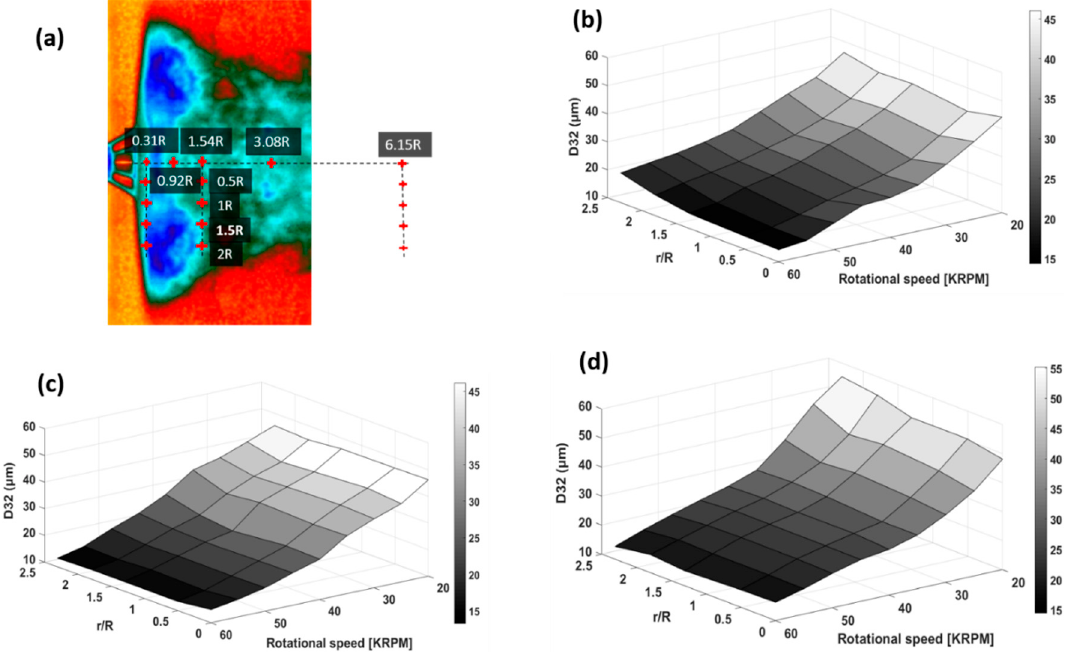
Figure 5. The variation of the D 32 for a fluid flow rate of 150 ccm with rotational speeds of the ERBS at different vertical locations within the spray flow field .